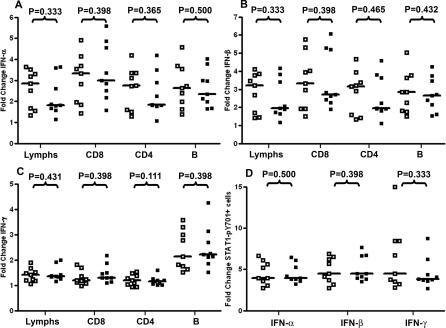
Fold Change in Mean Fluorescence Intensity of STAT1-pY701-Alexa Fluor 647 Staining in Lymphocytes from Patients with Melanoma and Healthy Controls in Response to IFN StimulationThe mean fluorescence intensity (MFI) of STAT1-pY701-Alexa Fluor 647 staining was measured by Phosflow in IFN-stimulated (1,000 IU/ml) and unstimulated cells. Total fold change = MFI stimulated cells/MFI-unstimulated cells; positive cell fold change = MFI STAT1-pY701-positive cells/MFI-unstimulated cells. p-Values were calculated using the Wilcoxon rank sum test (one-sided). Medians are indicated by the bar in each scatter column. Healthy (□; n = 9); melanoma (▪; n = 9).(A) IFN-α-stimulated cells.(B) IFN-β-stimulated cells.(C) IFN-γ-stimulated cells.(D) Positive cell fold change in lymphocytes.